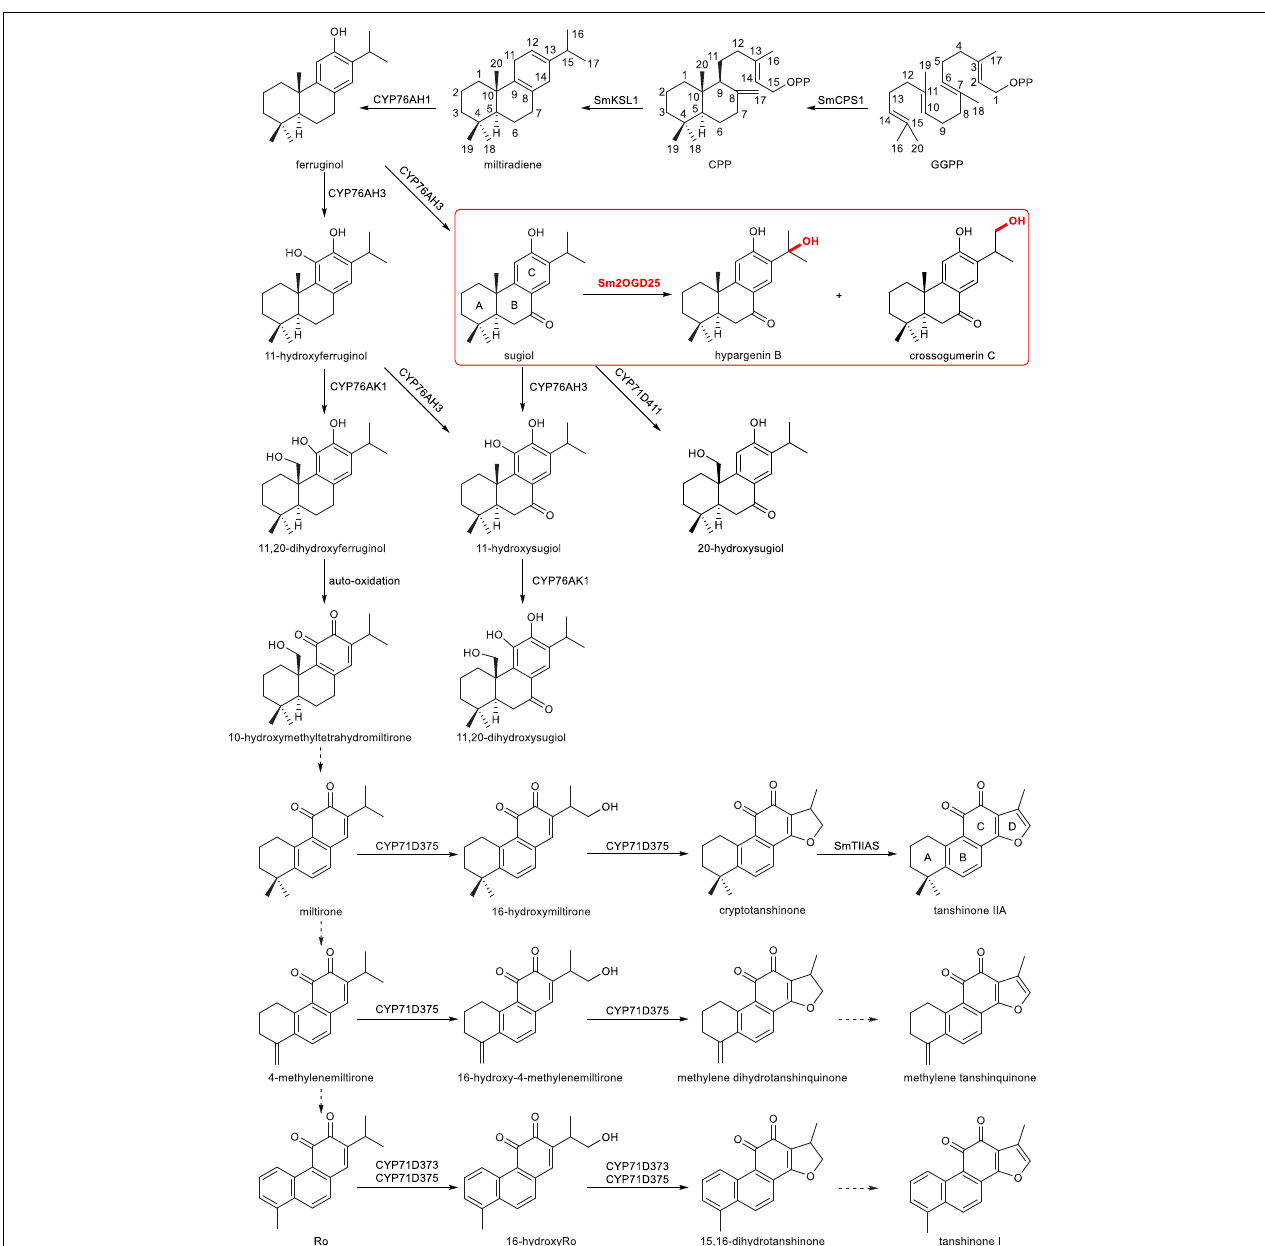
FIGURE 1 | Proposed biopathways of tanshinone-related diterpenoid biosynthesis in Salvia miltiorrhiza . Solid arrows indicate the established relationships, and dashed arrows indicate hypothetical relationships.